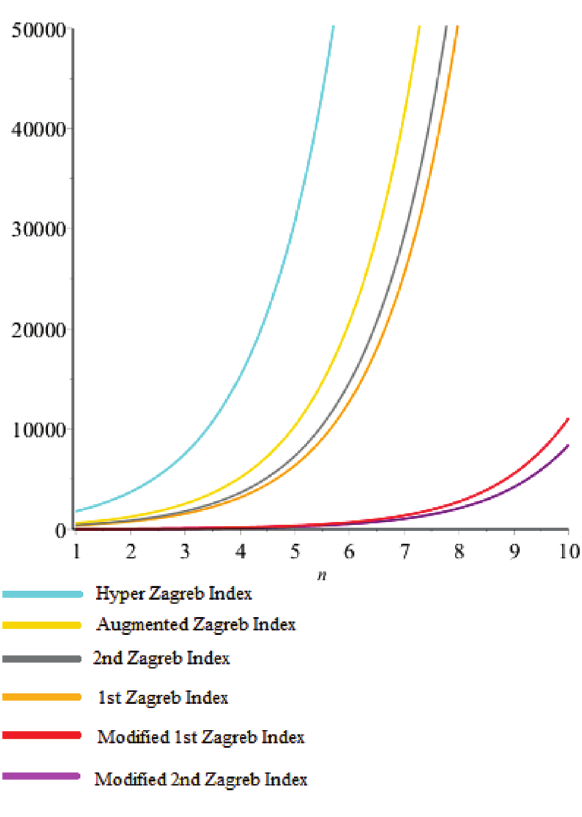
Figure 3: Comparison of Zagreb